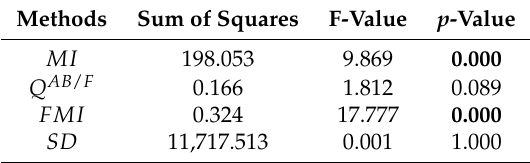
Table 4. ANOVA test for the quantitative assessment distributions of the “Lytro”